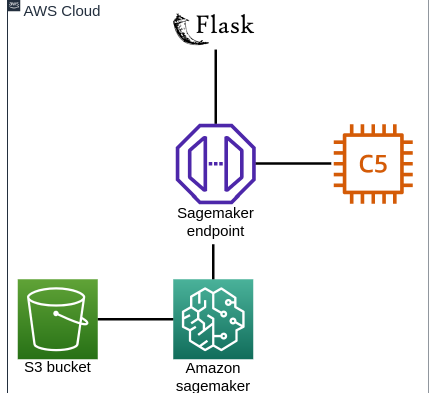
Figure 10. Model